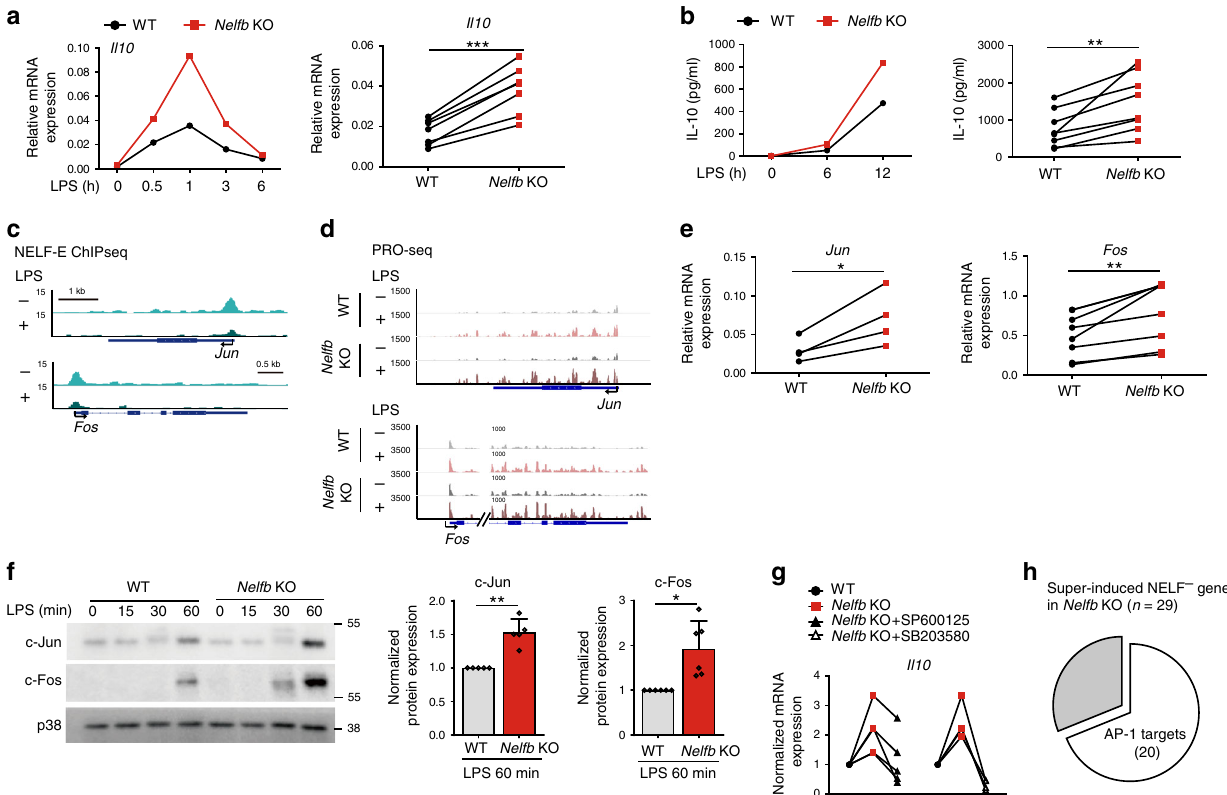
Fig. 6 NELF controls IL-10 expression by constraining the transcription of AP-1. a RT-qPCR analysis of Il10 mRNA in WT and Nelfb KO BMDM stimulated with LPS for indicated time. Representative (left) and cumulative (LPS 0.5 h, n = 7, P = 0.0002) (right) data are shown. b IL-10 protein ELISA in WT and Nelfb KO BMDM stimulated with LPS for indicated time. Representative (left) and cumulative (LPS 6 h, n = 8, P = 0.0066) (right) data are shown. c NELF-E ChIP-seq tracks Jun and Fos in resting ( − ) and LPS-activated ( + ) (0.5 h) BMDM. d PRO-seq (sense strand) tracks for Jun and Fos in WT and Nelfb KO BMDM cultured with ( + ) or without ( − ) LPS for 0.5 h. e Cumulative RT-qPCR data showing expression level of Jun ( n = 4, P = 0.0301) and Fos ( n = 6, P = 0.0039) in WT and Nelfb KO BMDM treated with LPS for 0.5 h. f Immunoblot analysis of c-Fos, c-Jun, and p38 in whole cell lysates of WT and Nelfb KO BMDM treated with LPS for indicated time (left: a representative result of fi ve replicates). For each replicate, c-Fos and c-Jun bands were quanti fi ed by densitometry at 60 min time point, normalized to internal control (p38) and expressed relative to WT ( = 1) (c-Jun P = 0.0041; c-Fos P = 0.0144). Mean + SD. g WT and Nelfb KO BMDM were pretreated with SP600125 (50 µ M) or SB203580 (20 µ M) for 0.5 h, where indicated, and Il10 expression following 0.5 h of LPS co-incubation was assessed by RT-qPCR ( n = 5). Relative Il10 expression was normalized to the levels in WT cells that were set as 1. h Out of 29, 20 NELF − genes super-induced in Nelfb KO are potential ( P < 0.001) AP-1 targets. * P < 0.05, ** P < 0.01, *** P < 0.001, N.S. P > 0.05 by two-sided